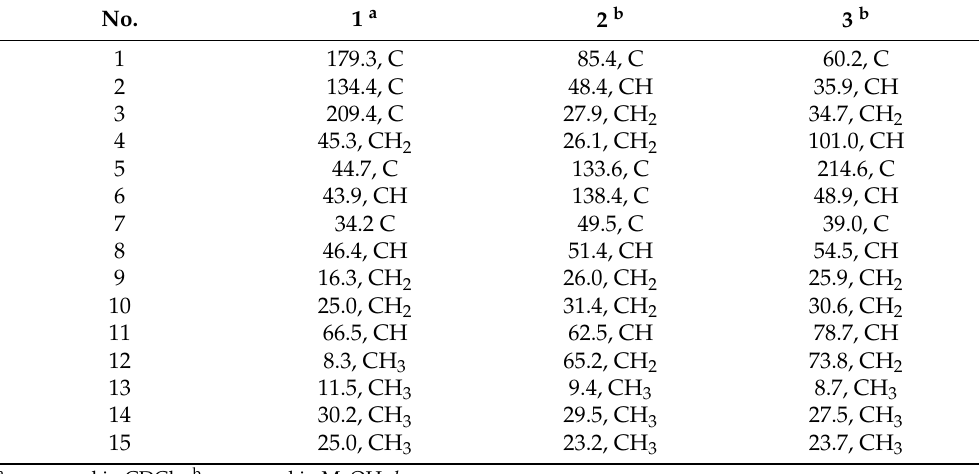
Table 2. 13 C NMR spectroscopic data of compounds 1 – 3 (125 MHz, δ in ppm).